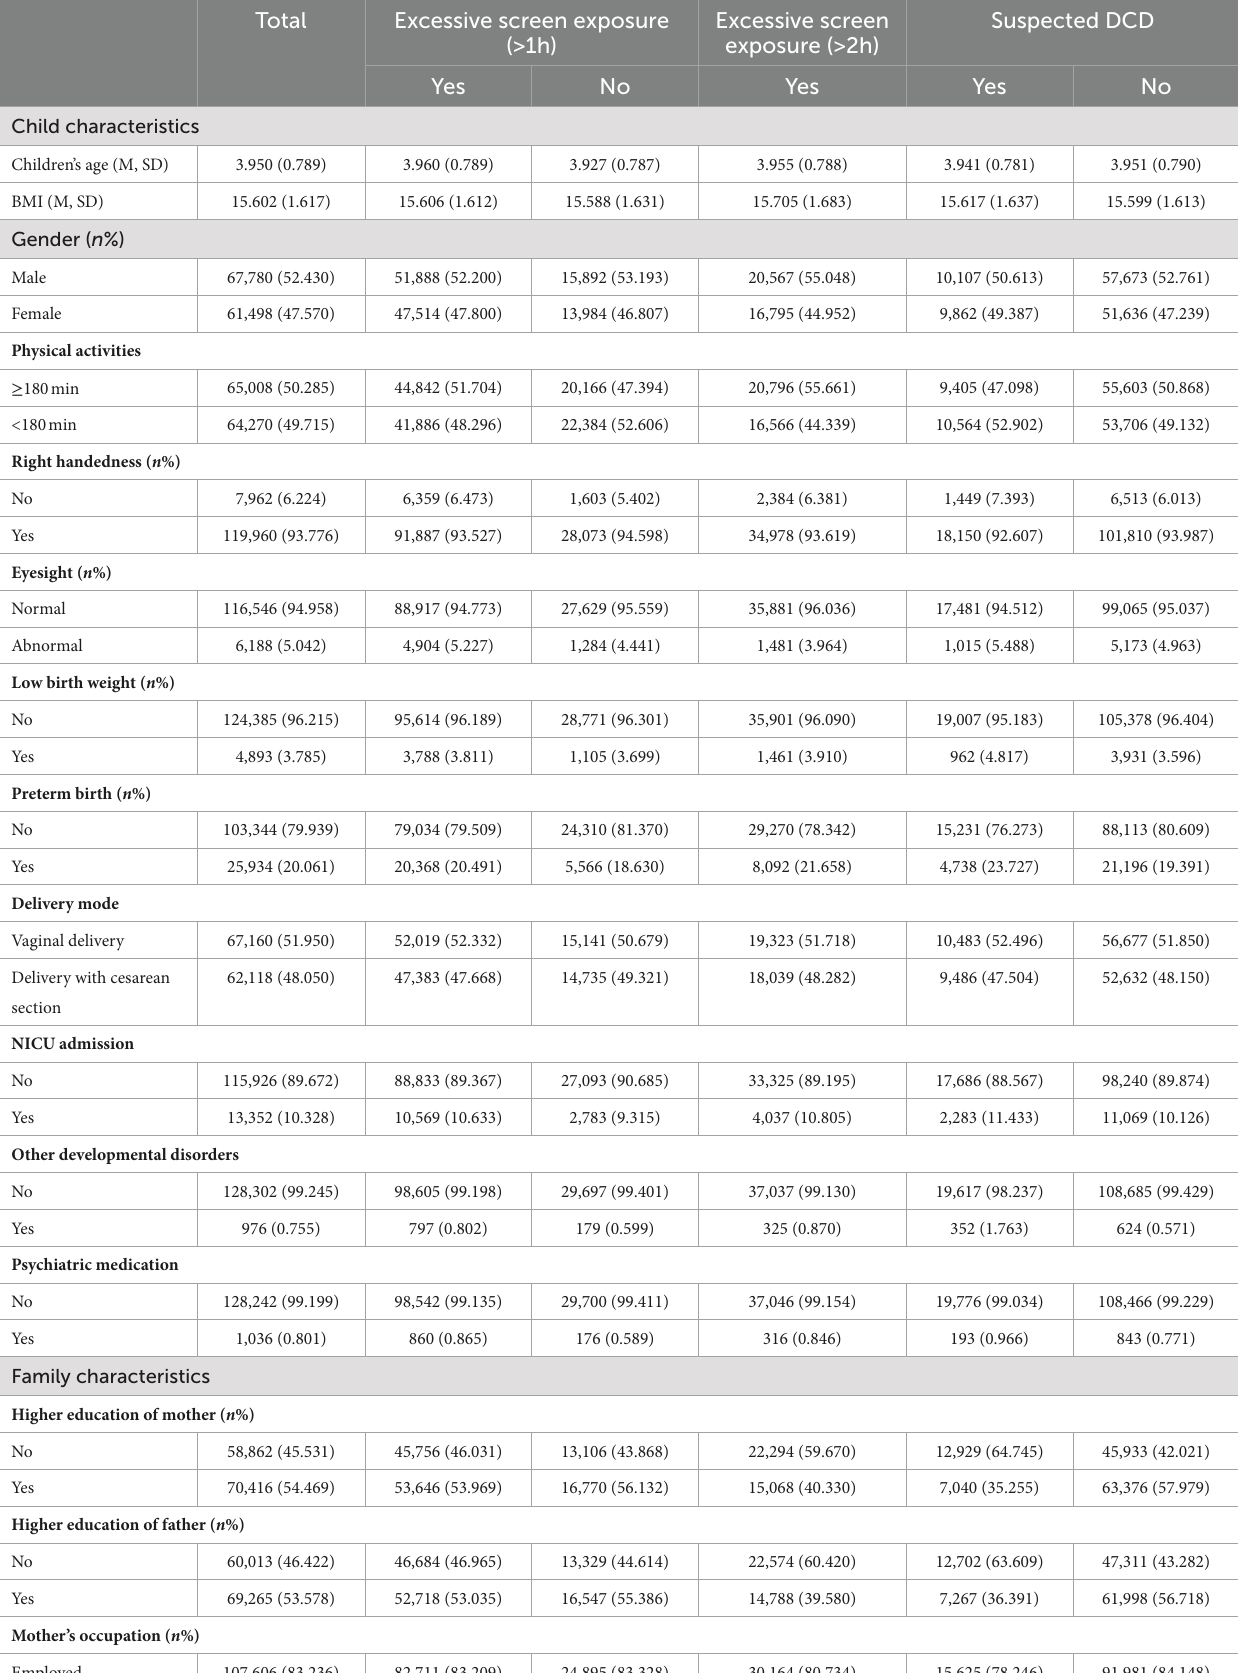
TABLE 1 The child, family characteristics and maternal health during pregnancy in the study population ( n = 129,278).